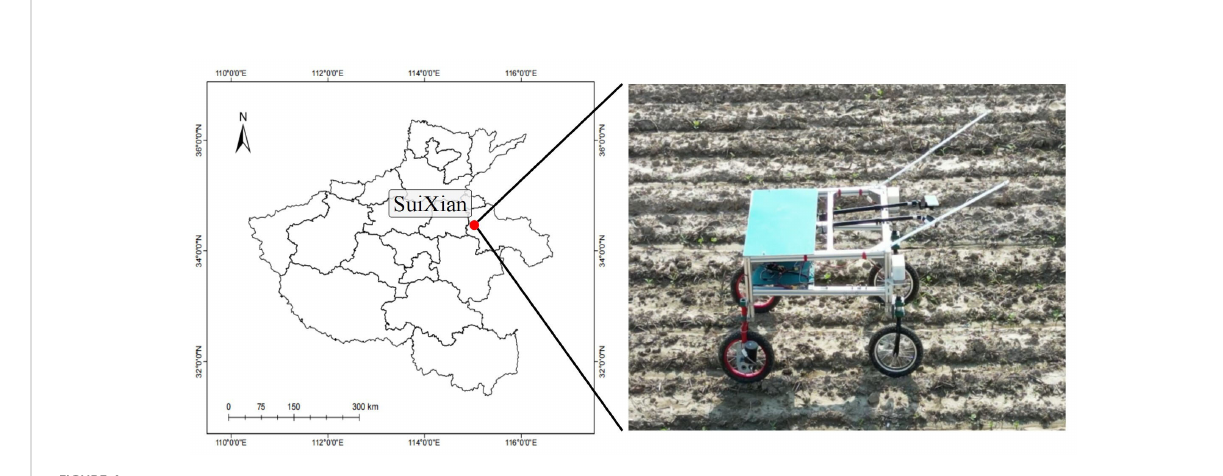
FIGURE 4 Remote-controlled fi eld image collection